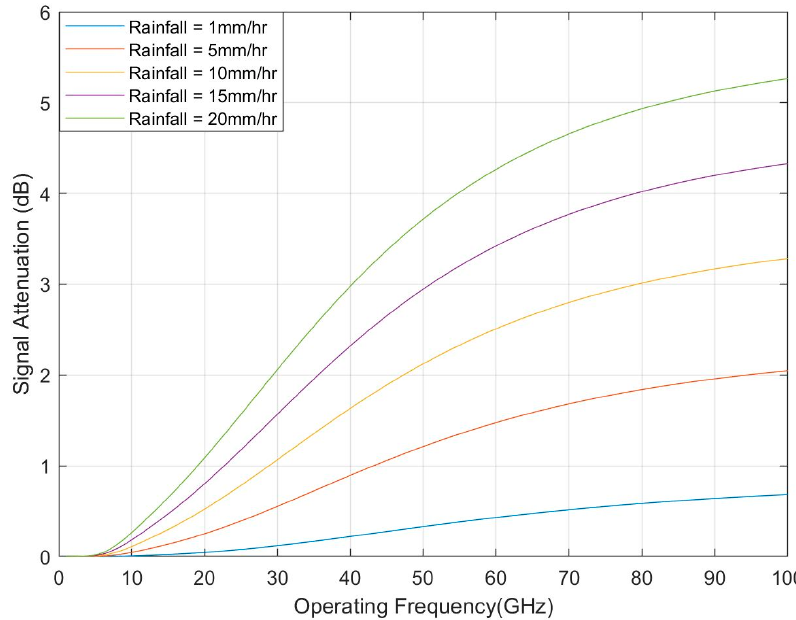
Figure 14. RF signal attenuation due to rainfall for different operating frequency.